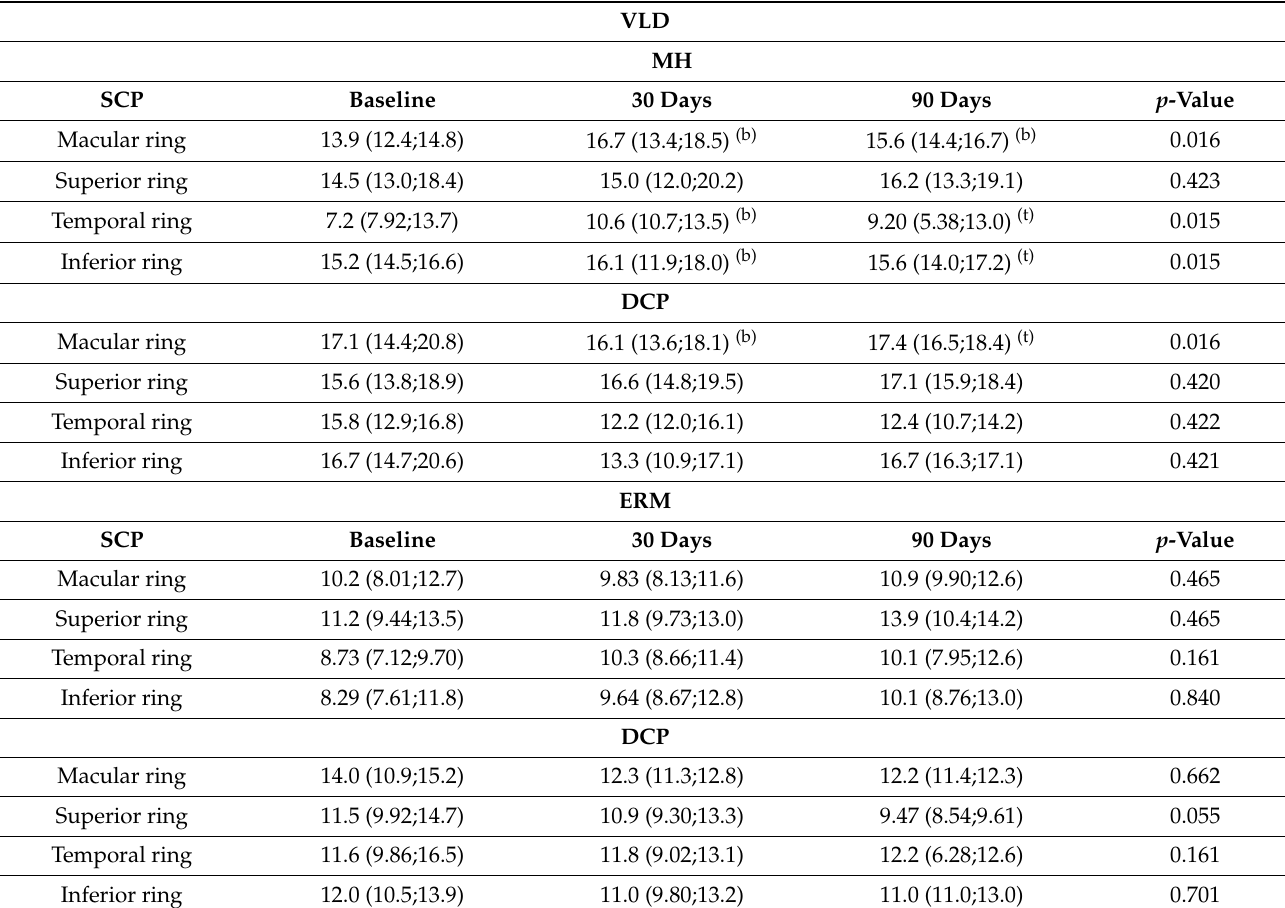
Table 3. Median and quartiles (Q1; Q3) for MH (macular hole) and ERM (epiretinal membrane) reported for baseline and up to 90 days, respectively, for every variable in the